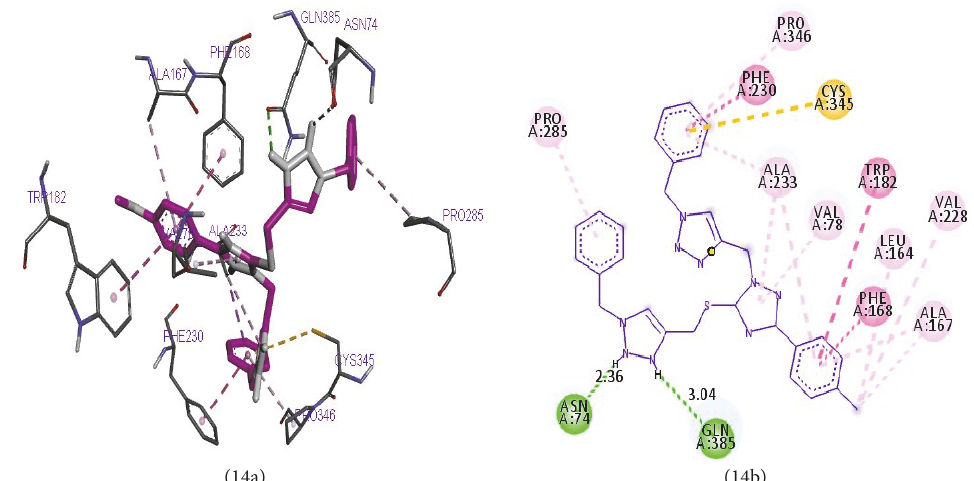
Figure 6: (7a) and (7b) show the 3D and 2D interactions between Mtb CYP121 and ligand 7. (8a) and (8b) show the 3D and 2D interactions between Mtb CYP121 and ligand 8. (13a) and (13b) show the 3D and 2D interactions between Mtb CYP121 and ligand 13. (14a) and (14b) show the 3D and 2D interactions between Mtb CYP121 and ligand